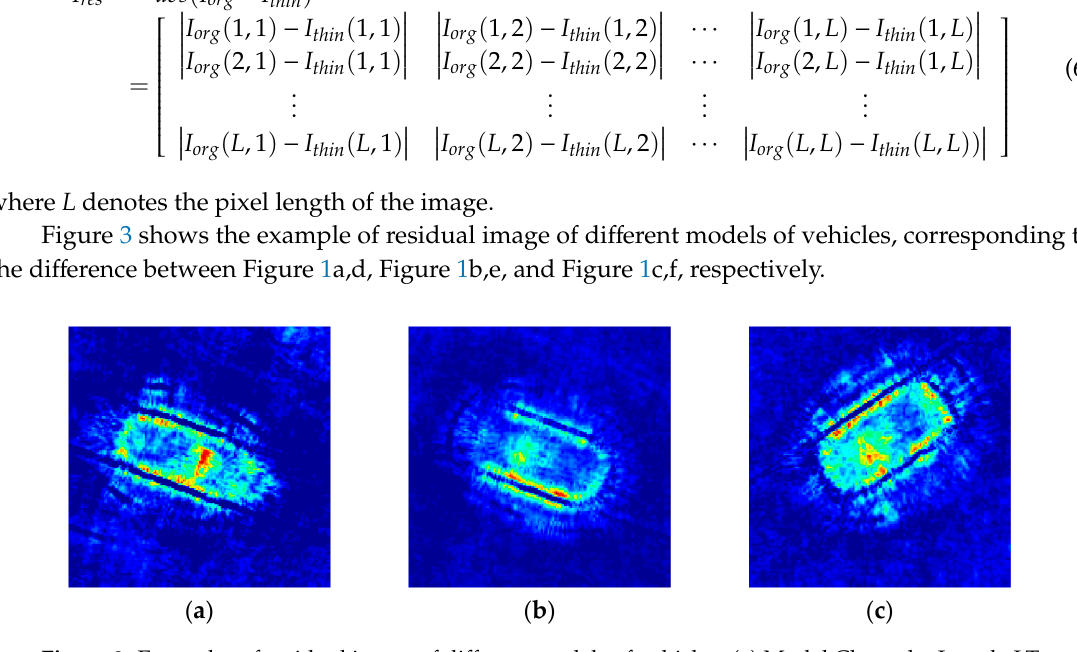
Figure 3. Examples of residual image of different models of vehicles: ( a ) Model Chevrolet Impala LT, corresponding to the difference between Figure 1a and Figure 1d; ( b ) Model Mitsubishi Galant ES, corresponding to the difference between Figure 1b and Figure 1e; ( c ) Model Toyota Highlander, corresponding to the difference between Figure 1c and Figure 1f.